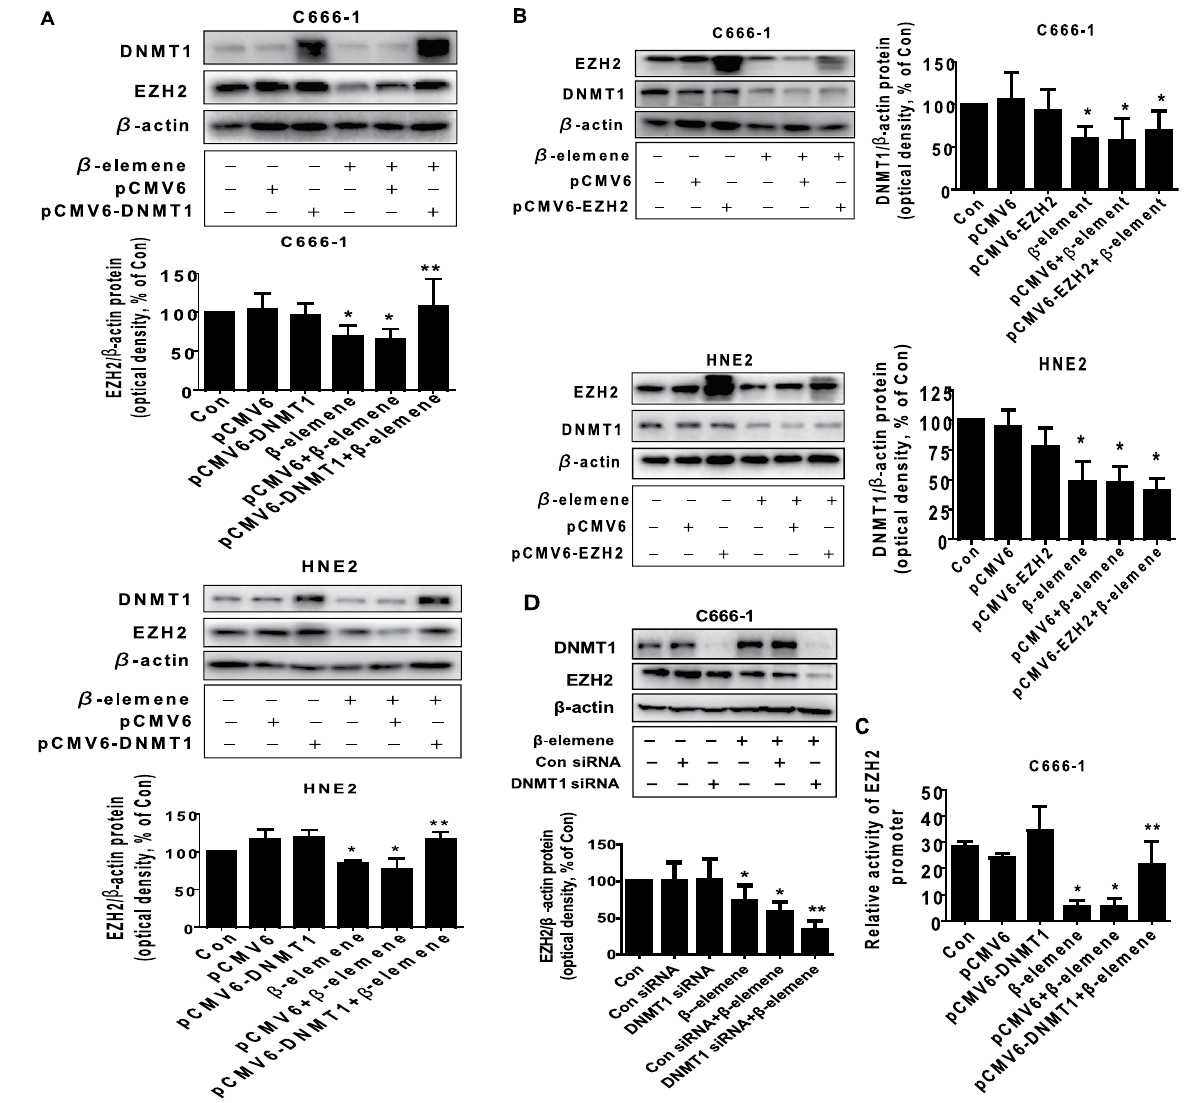
Figure 4. Exogenously expression of DNMT1 overcame the effect of β -elemene on EZH2 protein expression and promoter activity. ( A,B ) C666-1 and HNE2 cells were transfected with control or DNMT1 or EZH2 expression vectors for 24 h prior to exposure of the cells to β -elemene (20 μ g/mL) for an additional 24 h. Afterwards, Western blot analysis were used measure the protein levels of DNMT1 and EZH2 using corresponding antibodies. ( C ) C666-1 and HNE2 cells were transfected with control or DNMT1 expression vector, and with a wild type human EZH2 promoter reporter construct ligated to luciferase reporter gene and internal control secreted alkaline phosphatase for 24 h, followed by treating with β -elemene (20 μ g/ mL) for an additional 24 h. Afterwards, the promoter activities were determined using the Secrete-Pair Dual Luminescence Assay Kit as described in the Materials and Methods section. ( D ) C666-1 cells were transfected with control or DNMT1 siRNA for 24 h prior to exposure of the cells to β -elemene (20 μ g/mL) for an additional 24 h. Afterwards, Western blot analysis were used for determining the protein levels of DNMT1 and EZH2 using corresponding antibodies. The figures are representative cropped gels/blots that have been run under the same experimental conditions. Values in bar graphs were given as the mean ± SD from three independent experiments performed in triplicate. * Indicates significant difference as compared to the untreated control group (P < 0.05). ** Indicates significant difference from the β -elemene treated alone (P <